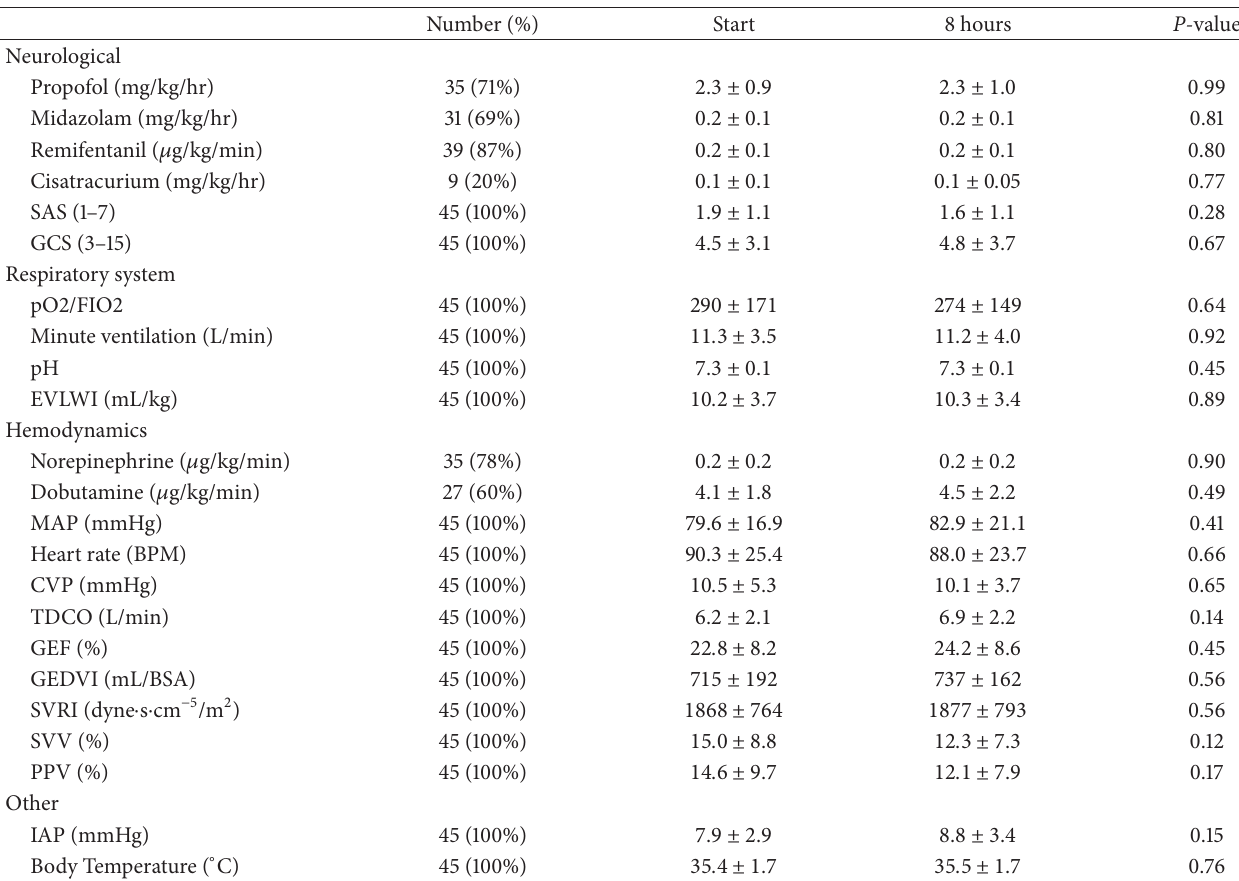
Table 2: Comparison of several neurological, respiratory, and hemodynamic variables and dose of the used drugs between the start and the end (at 8 hours) of the study